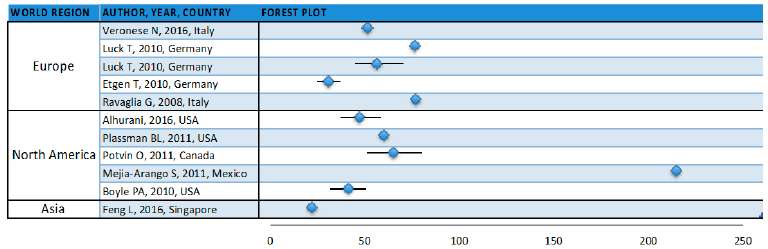
Figure 3. Incidence of cognitive impairment reported by the 11 included studies, which are grouped by world region (the 95% confidence intervals were obtained from papers or calculated with the data